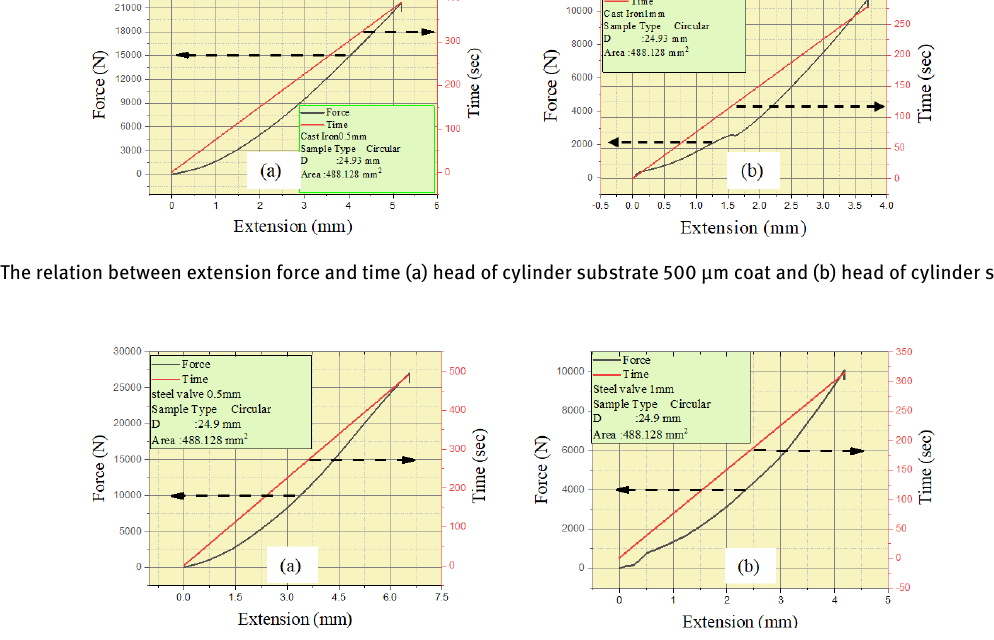
Figure 17: The relation between extension force and time (a) valve substrate 500 µ m coat and (b) valve substrate 1000 µ m